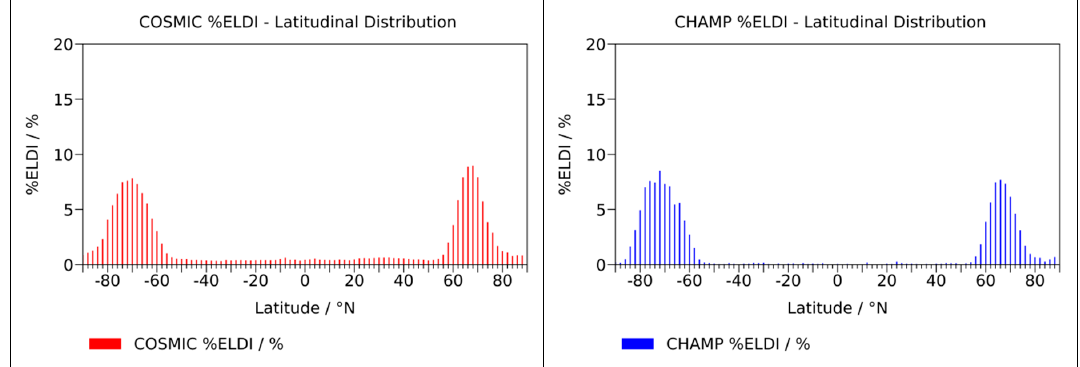
Figure 3. Latitudinal distribution of E layer dominated ionosphere (ELDI) events. ( Left panel ) COSMIC (data from 2006 to 2018); ( right panel ) CHAMP (data from 2001 to 2008).